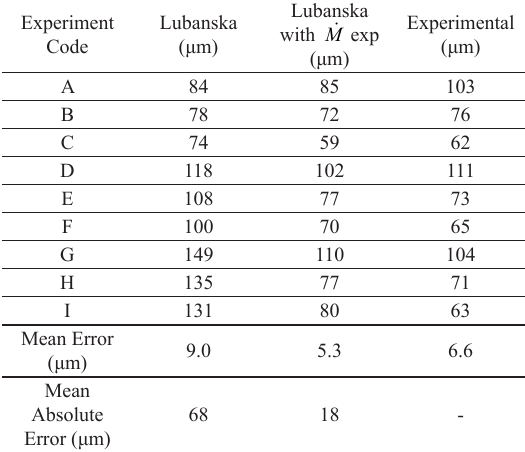
Figure 1. Experimental v.s. Lubanska d50 values. The data labels represent the gas pressure and tip diameter of each experiment. Table 3. Lubanska and experimental d50 values with their mean and mean absolute